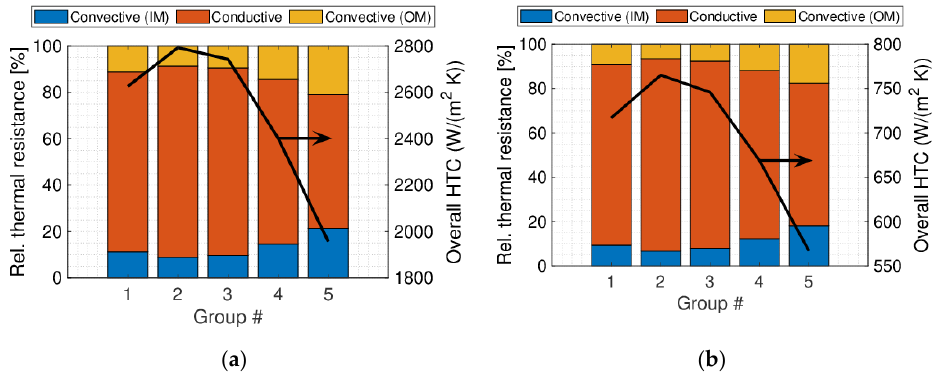
Figure 12. Distribution in the poloidal direction of the overall HTC (right axis) and of the relative contribution of the three terms to the total thermal resistance (left axis): ( a ) FW manifolds; ( b ) BZ manifolds.